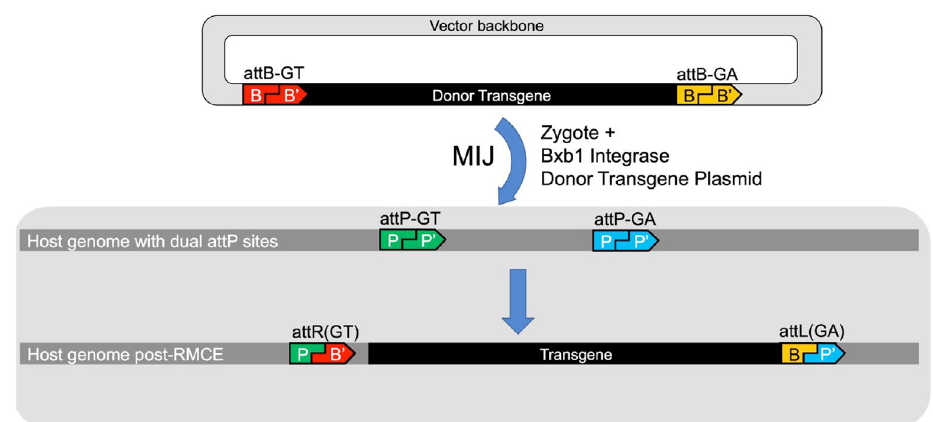
Figure 5. Schema for the use of dual attP-GT/attP-GA mouse strains targeted for transgenesis by RMCE. Bxb1 integrase mRNA and the vector carrying the donor transgene (flanked by dual attB-GT, attB-GA sites) are microinjected into zygotes carrying the cognate attP-GT, attP-GA sites. Upon integration, RMCE excludes the vector backbone and results in the precise integration of the desired donor transgene into the ROSA26